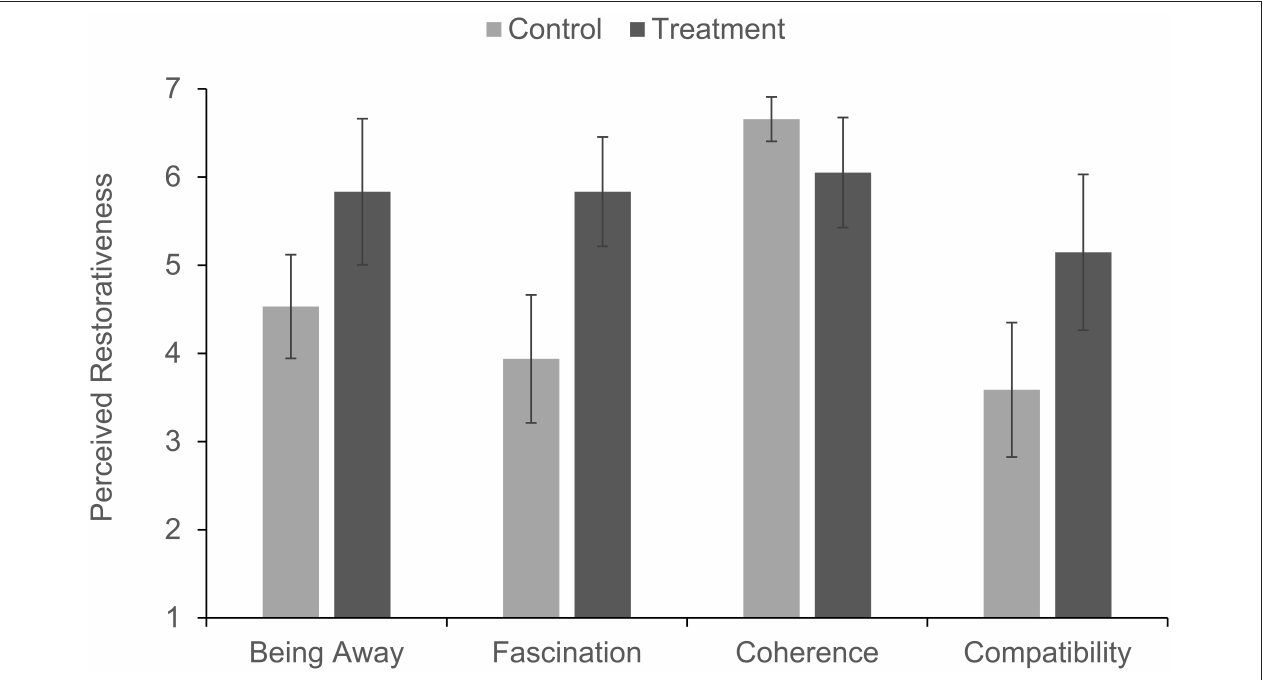
FIGURE 3 | Perceived restorativeness by subscale by condition. Error bars represent 95% confidence intervals (95% CI).